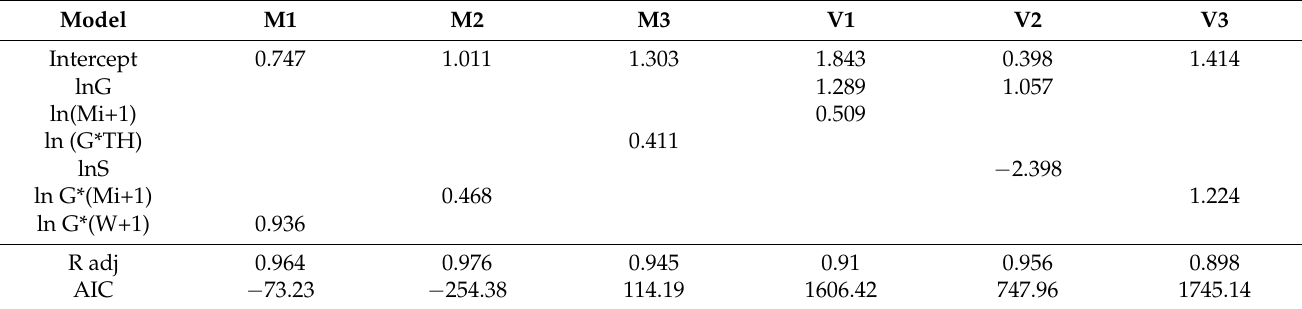
Table 4. Selected models for each site without considering species